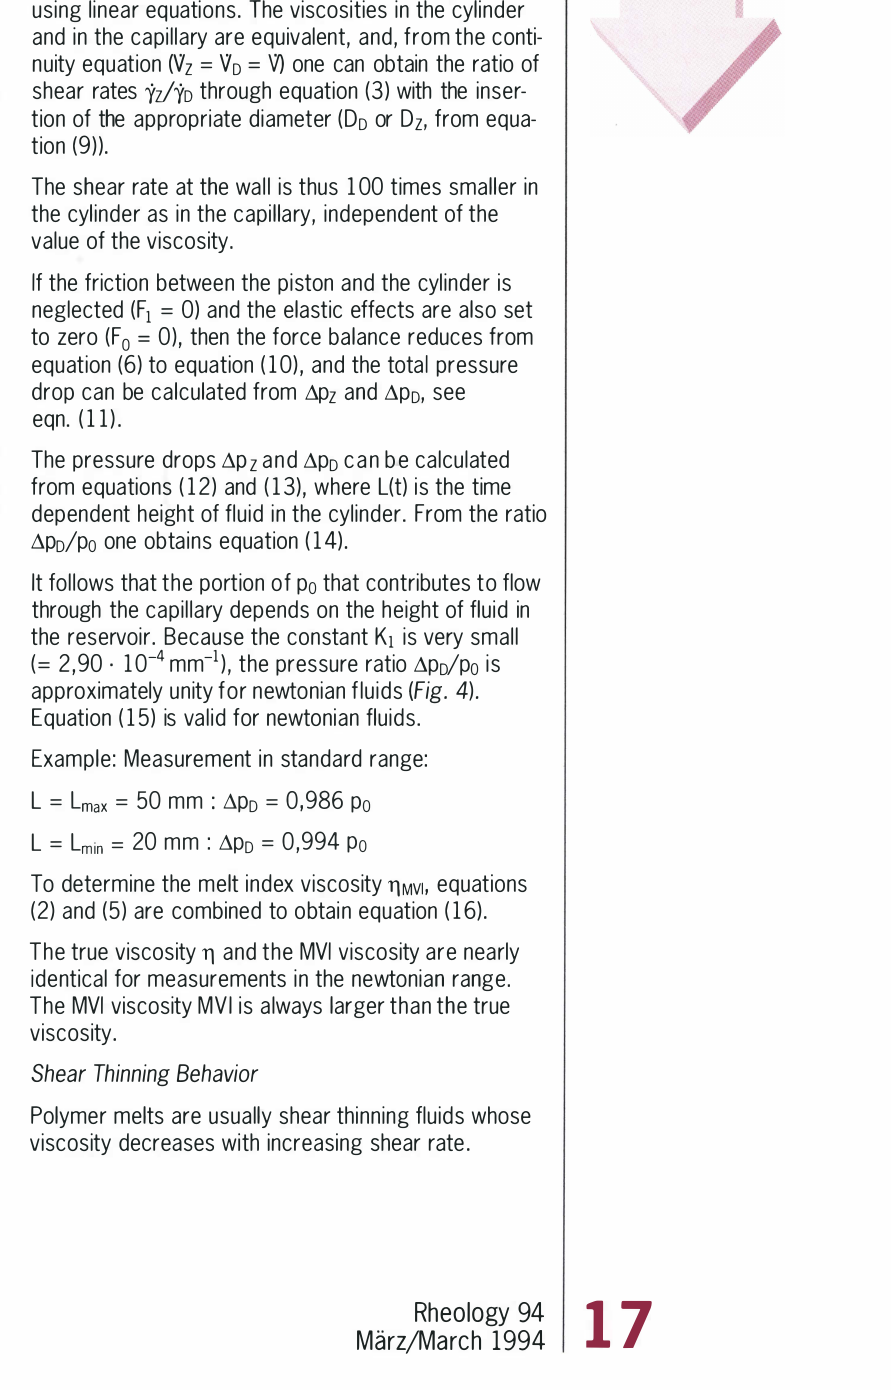
Newtonian Fluids